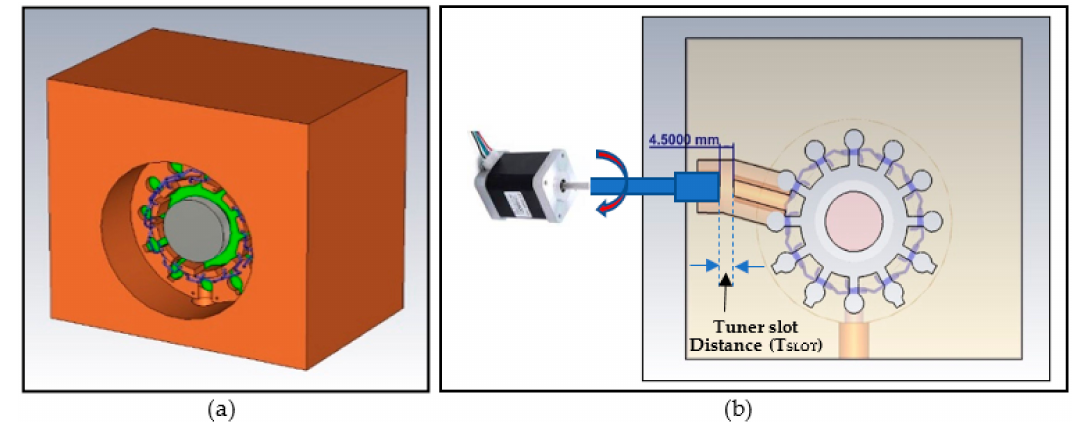
Figure 8. The twelve-hole-slot-type magnetron modeling. ( a ) 3D visual model; ( b ) tuning system of